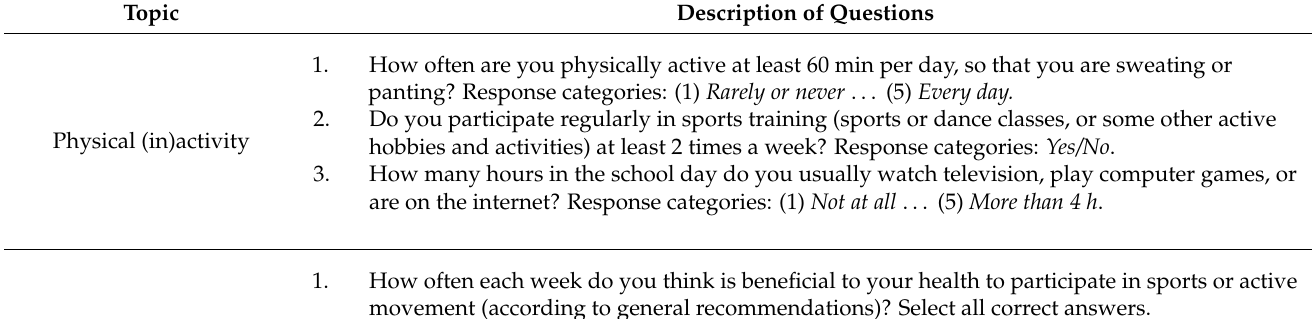
Table 1. Student-level items used to measure physical activity and knowledge. Description of Questions